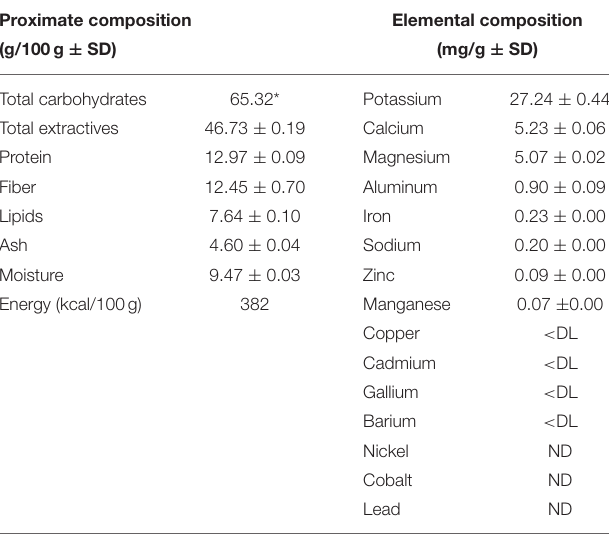
TABLE 2 | Extraction yields (%) from Red eggplant obtained by ohmic heating and conventional heating extraction with different solvents: water, ethanol (EtOH) and methanol